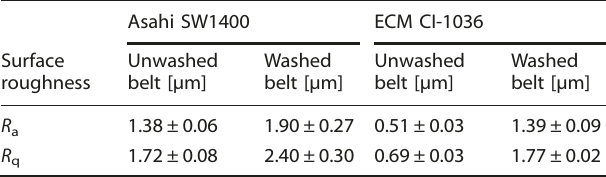
Table 2. Surface roughness comparison of washed and unwashed belts.